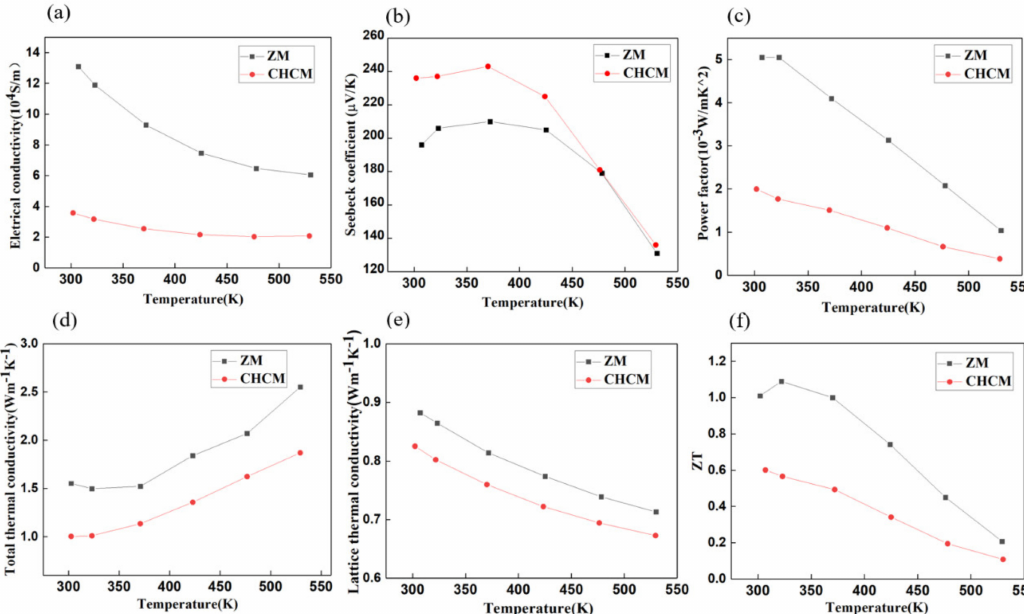
Figure 8. Thermoelectric properties of the CHCM sample with 30% deformation and the ZM sample. ( a ) Electrical conductivity, ( b ) Seebeck coefficient, ( c ) power factor, ( d ) total thermal conductivity, ( e ) lattice thermal conductivity, ( f ) ZT value.